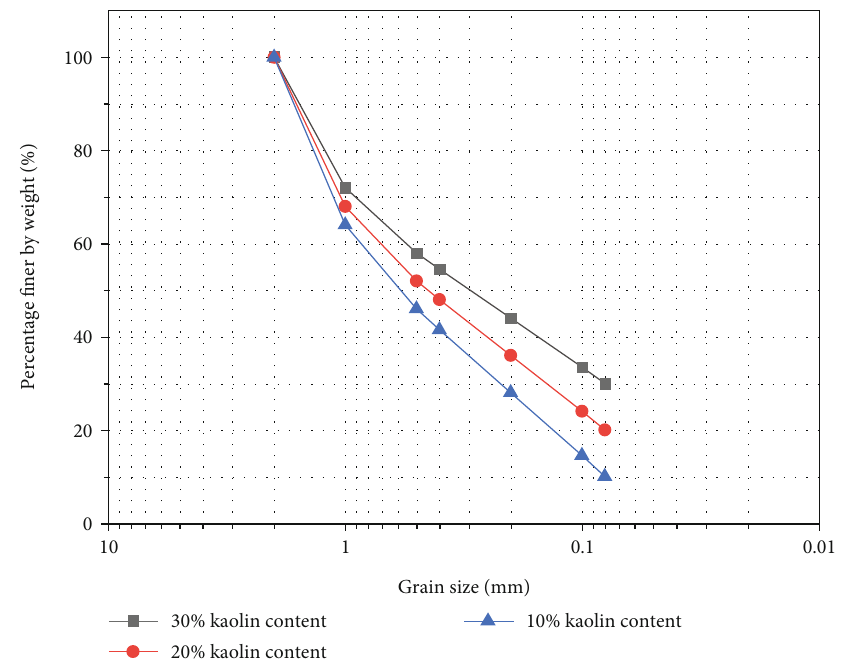
Figure 2: Grading curves of fi lling medium with di ff erent kaolin contents. Table 2: Basic components of clay-sand-type fi lling